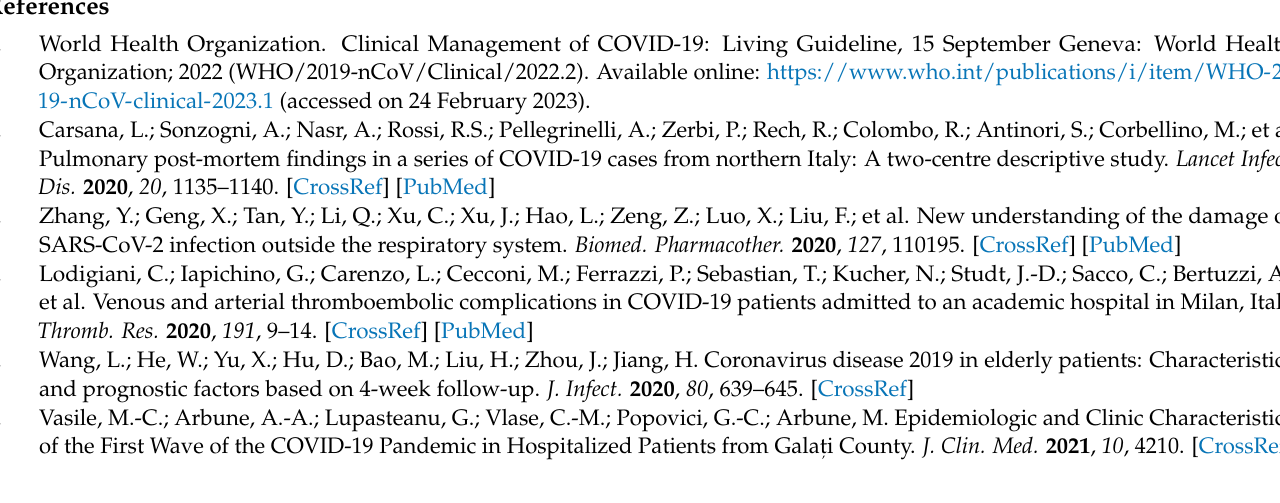
Figure A3. PRISMA FLOW DIAGRAM for systemtic reviews